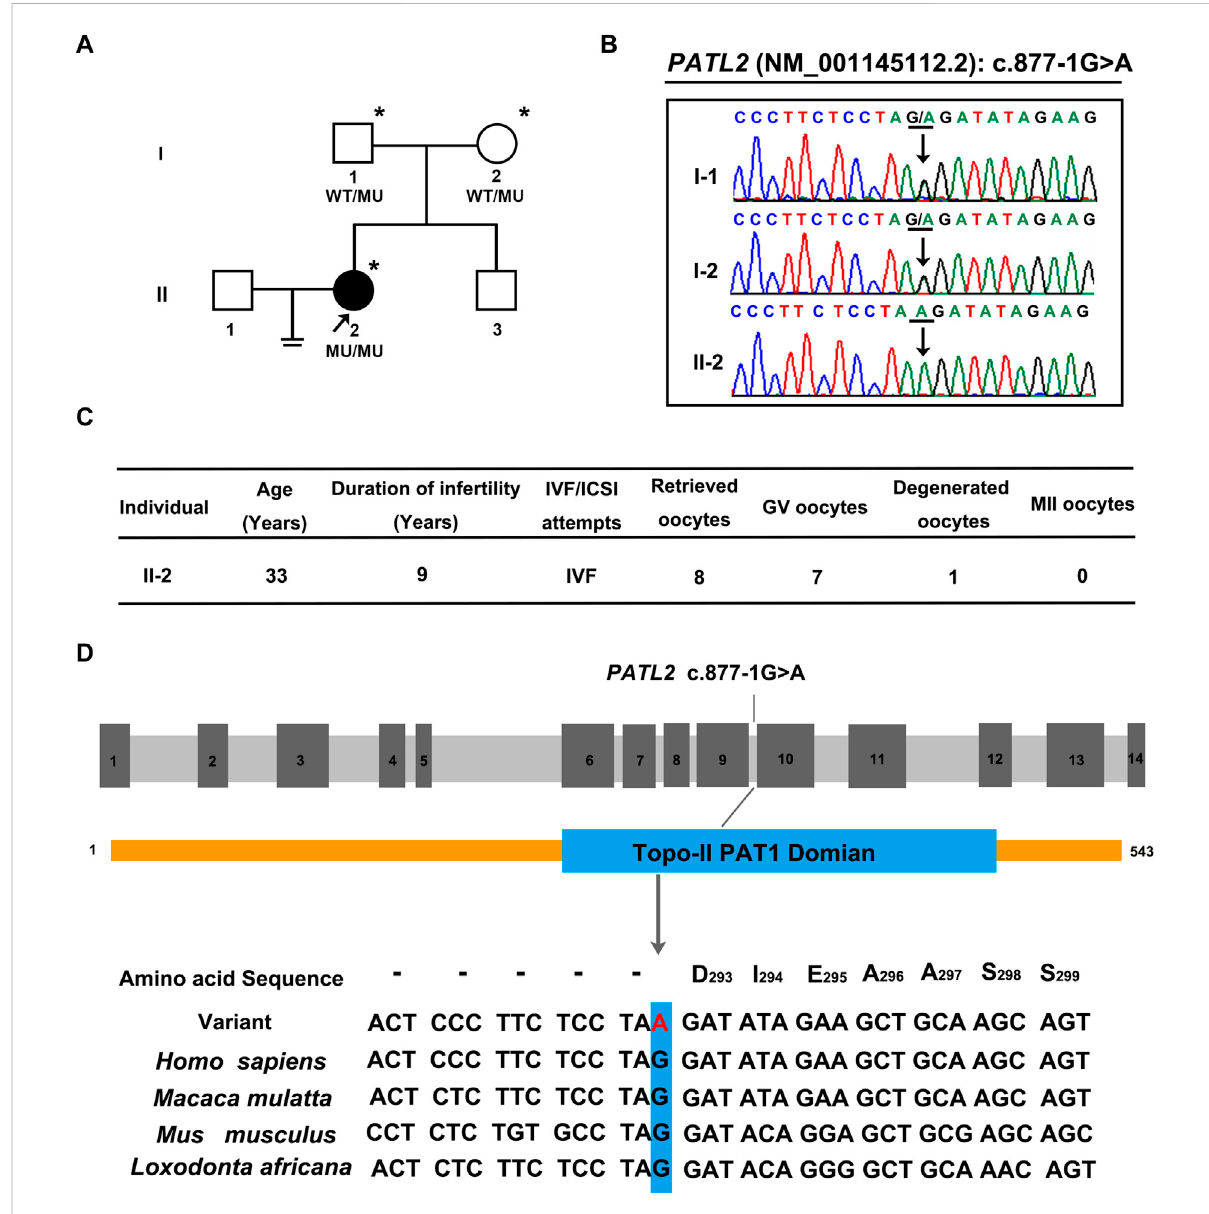
FIGURE 2 Pedigrees, clinical characteristics, and detection of variants in the female infertility family with oocyte germinal vesicle arrest. (A) Pedigrees of theaffectedfamily.Thesquares,circles,blackened,andopensymbolsindicatemales,females,andaffectedandunaffectedindividuals,respectively. The arrows indicate the proband (II-2), and the asterisks denote the individuals who underwent genotyping. (B) Sequencing chromatograms of affected individuals who were homozygous for PATL2 variant. Her father and mother were heterozygous carriers of the identi fi ed splicing variant.Theblackarrowsindicatethesitesofthevariants. (C) clinicalcharacteristicofaffectedindividualandtheretrievedoocytesintheIVFcycle. (D) The detected variant (C) 871-1G > A in PATL2 (MIM: 614661; GenBank: NM_001145112.2) in the affected family is evolutionarily conserved across different species. The site of PATL2 variant is indicated in blue